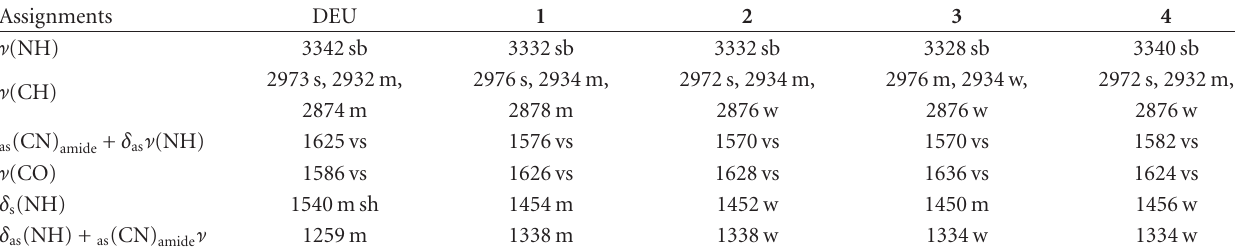
Table 10: Most characteristic and diagnostic IR fundamentals (cm − 1 ) for DEU and complexes 1 – 4 . a